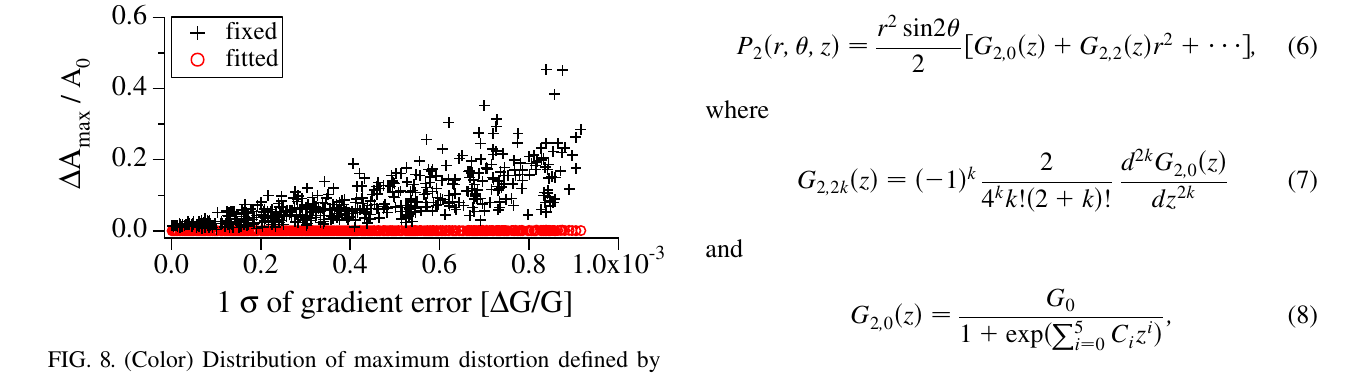
FIG. 8. (Color) Distribution of maximum distortion defined by the fixed and fitted lattice functions out of 501 different gradient errors. Initial emittance is 0 : 003 (cid:1) mm rad .